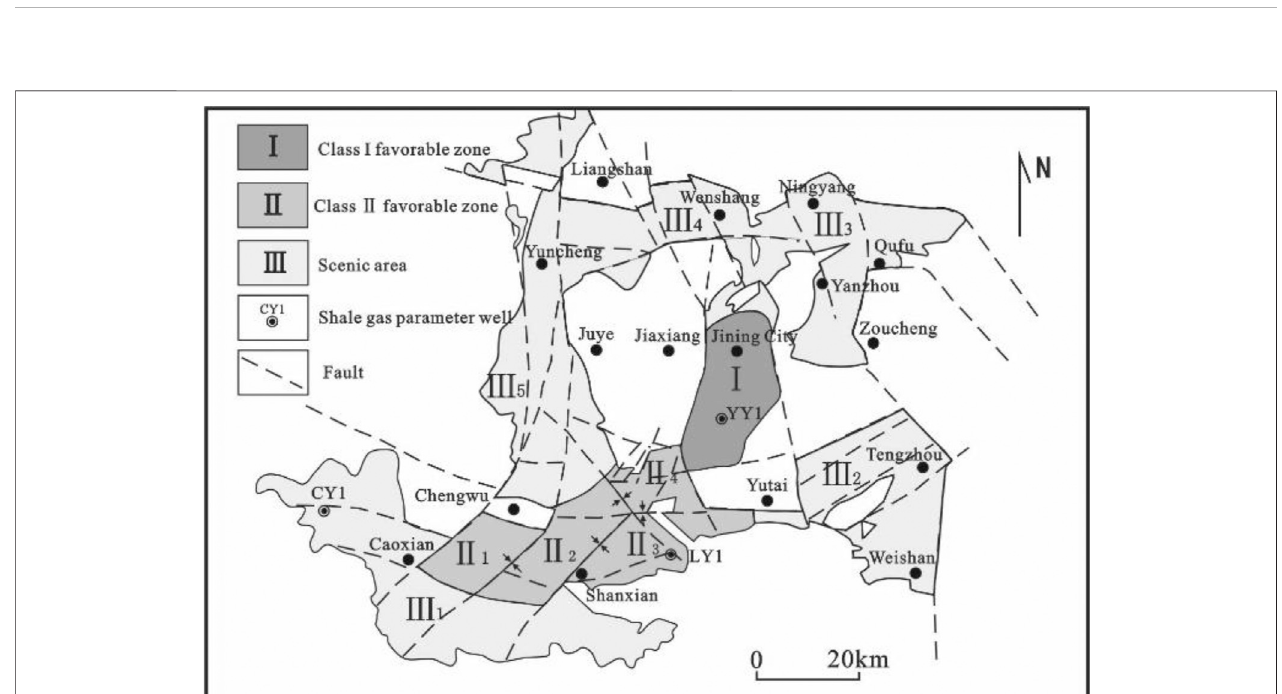
FIGURE 11 | Distribution map of the prospective and favorable shale gas areas in the western Shandong